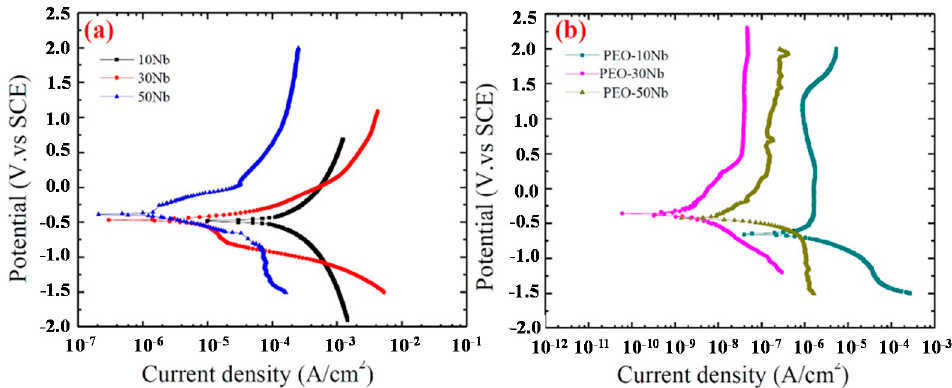
Figure 14. ( a , b ) Potentiodynamic polarization curves of the Ti- x Nb alloys before and after PEO treatment, respectively. Passive regions were observed in the case of the PEO-coated Ti- x Nb alloys. Reprinted from [156], copyright (2019), with permission from Elsevier.